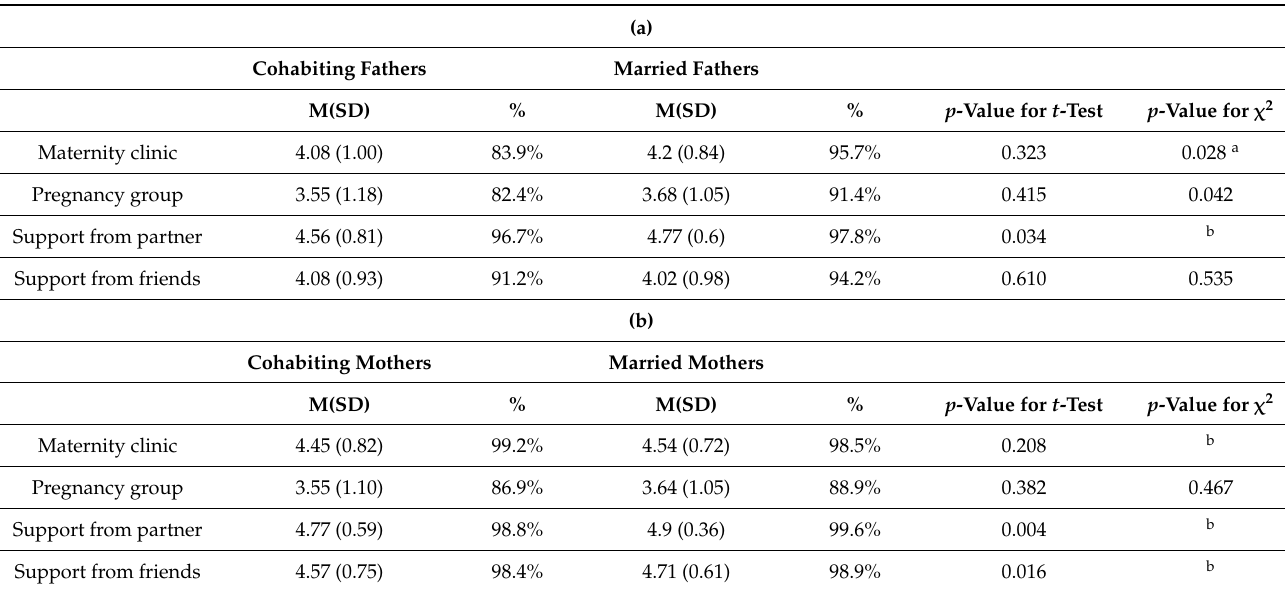
Table 6. ( a ). Use and rating of support, cohabiting and married fathers. ( b ) Use and rating of support, cohabiting and married